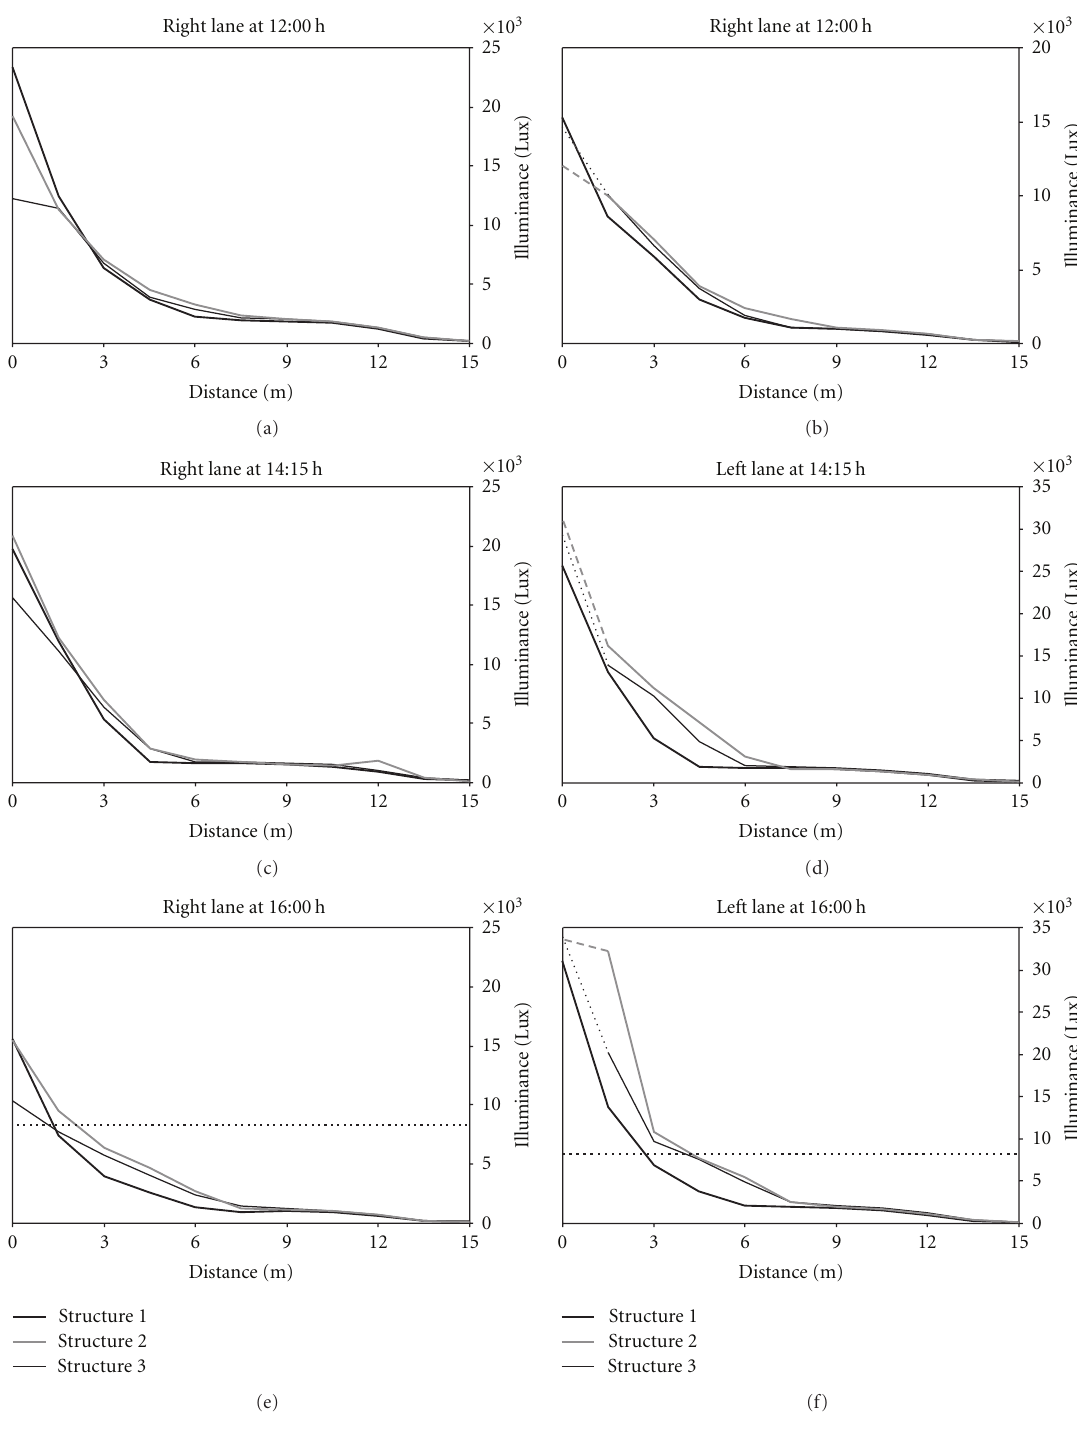
Figure 7: Illuminance values (lux) depending on the distance to the entrance in the centre of the right lane and the centre of the left lane for the N-S